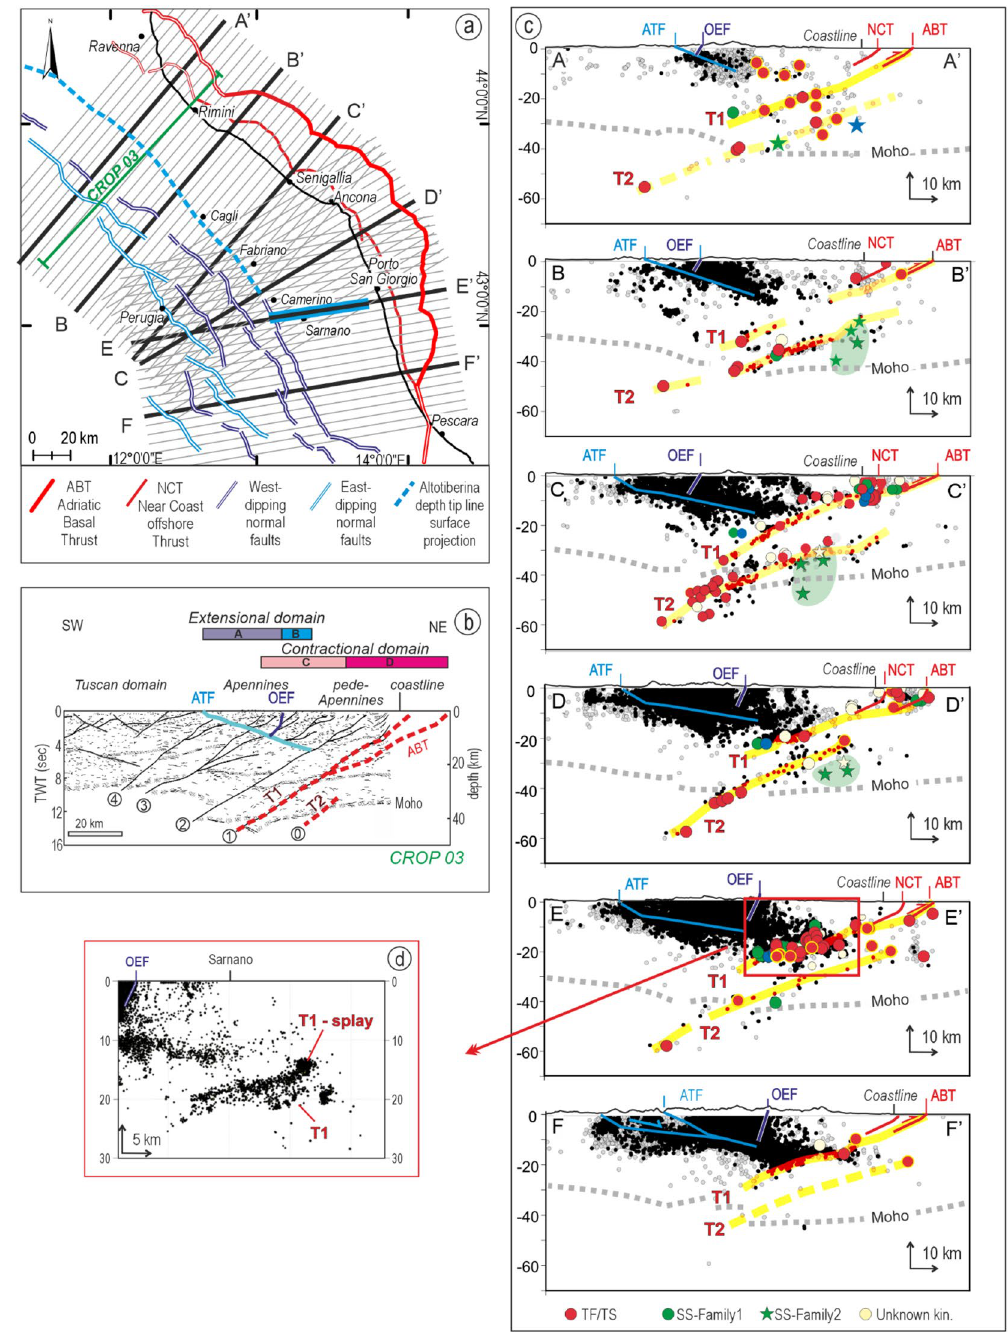
Figure 3. Hypocentral cross-sections and inferred earthquake-fault association (Data from EQS- and MFS-Catalogs in this paper). ( a ) Map-view traces of 70 narrowly spaced radial cross-sections and six regional transects (A–F) used to build the 3D fault model. ( b ) Line-drawing of the near-vertical CROP-03 seismic reflection line across the northern sector of the ABT 18 ; thrust numbered from 4 to 1 progressively rejuvenate in an age moving eastward from middle Miocene (thrust 4) to late Pliocene–Quaternary (thrust 1); T1 and T2 as in ( c ); ( c ) Section-view projection (within 20 km of the trace line) of earthquakes and focal mechanisms from this study (EQS- and FMS-Catalogs ), plus focal solutions in the 1967–2009 time interval from the literature 42,43 (e.g., yellow bordered circle). Key: black dots = Subset-1 data; grey dots = Subset-2 data; colored dots = focal mechanisms with kinematic color code as in Fig. 2b (Red = reverse, blue = normal, green = strike-slip, light yellow = unknown kinematics); green dots = strike-slip Family1 with SW–NE P-axes trending; green stars = strike-slip Family2 (deep-SS) with NNW–SSE P-axes trending; OEF = trace of Outcropping west-dipping Extensional Front. The yellow lines enveloping hypocenters and focal mechanisms offer a section view of the ABT (T1) and the underlying hidden lithospheric thrust identified in this paper (T2); the Moho depth line is from Di Stefano et al. 69 . ( d ) Detail from transects E showing the intersection zone between T1 and T1-splay; the hypocenters from EQS-Catalog are projected with a half-width of 2.5